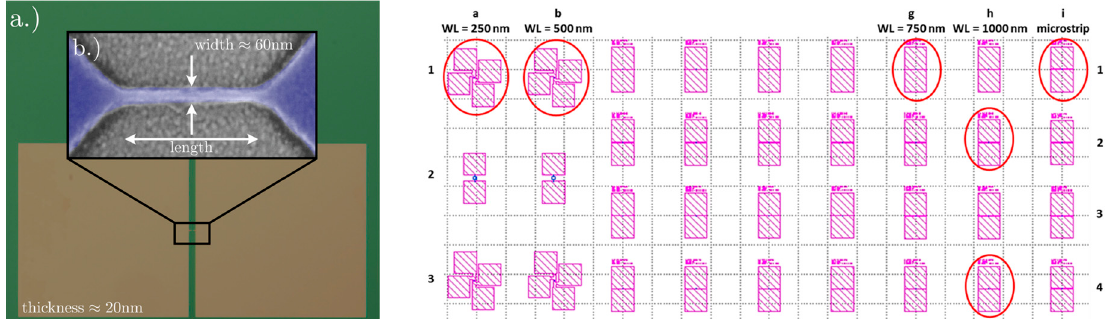
Figure 1. (Left panel) Colorized optical picture of a device investigated. The colorized scanning electron microscope image of a typical nanowire is shown in the enlargement. The wire is 20 nm thick and it has a typical width up to 60 nm. (Right panel) Layout of the chip. The measured nanowire samples are evidenced by the circles. The contacts are made by 50 µ m thick with aluminum wire by ultrasonic bonding.